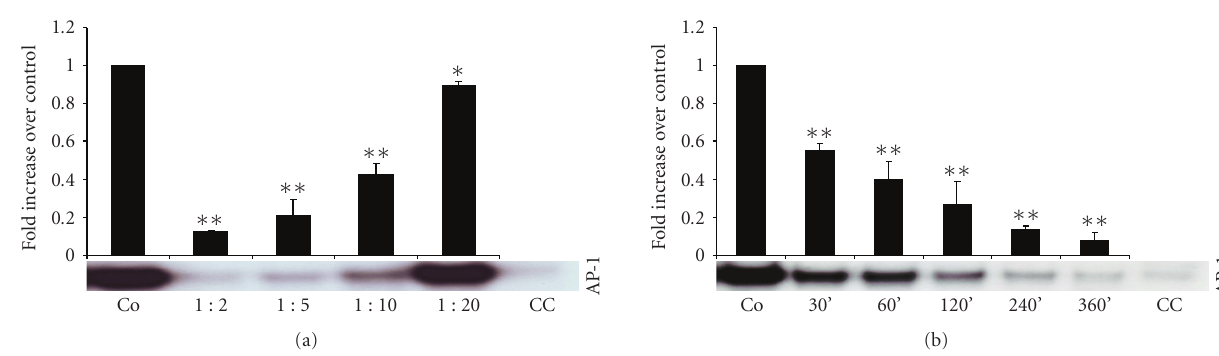
Figure 2: Binding activity of the transcripton factor AP-1 in nuclear extracts of LPS-stimulated RAW 264.7 cells. E ff ects of total extract of Rhizoma coptidis was evaluated with di ff erent concentrations (incubation time 240 min), (a) and exposure times (dilution 1 :5), (b) and was compared with transcription factor activation in LPS-stimulated control cells. Values represent results from at least three independent experiments. AP-1: activated protein-1, Co: LPS-stimulated control cells, and CC: cold competition. ∗ P < . 005, ∗∗ P < . 001.